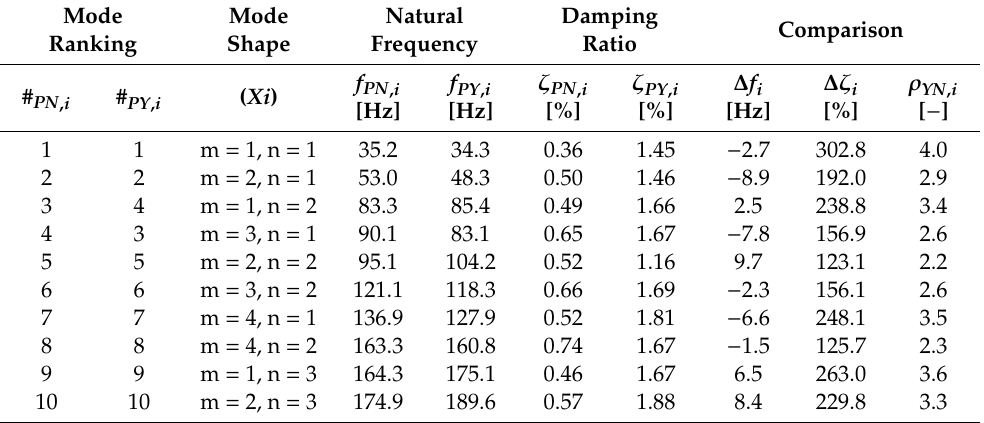
Table 4. Modal parameters estimated from shaker tests experimental modal analysis (EMA).